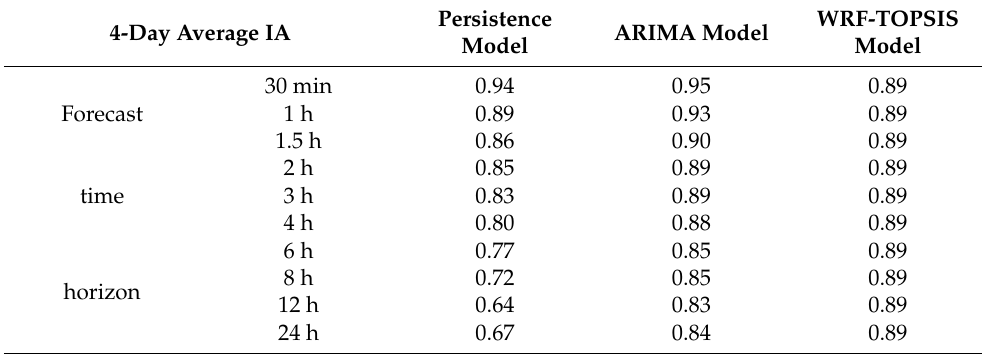
Table 10. Four-day average index of agreement for the wind speed forecasting using the persistence, ARIMA, and WRF-TOPSIS models applied to the 4-day test dataset.